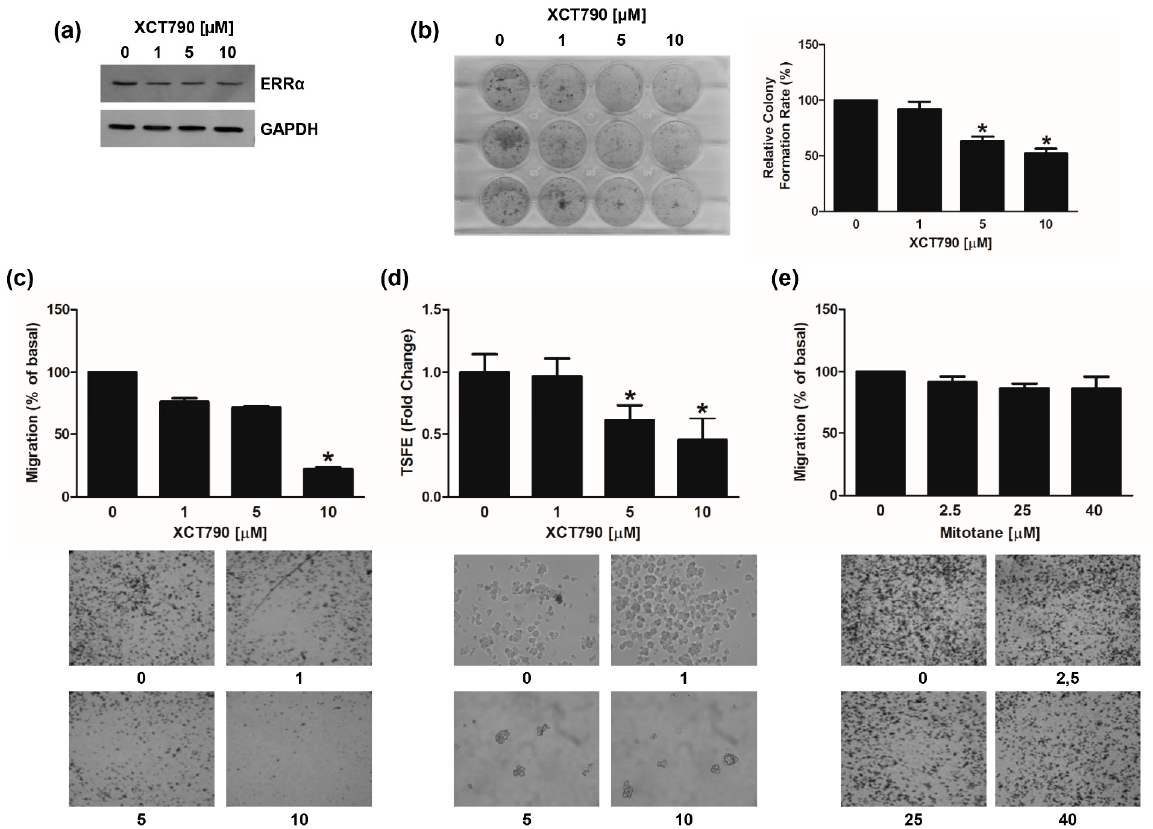
Figure 8. Effects of XCT790 treatment on MUC-1 cells. ( a ) MUC-1 cells were left untreated (0) or treated with XCT790 (1, 5, 10 µM) for 24 h. Total proteins were analyzed by WB using antibodies against ERR α . GAPDH was used as a loading control. Blots are from one experiment representative of three with similar results. ( b ) MUC-1 cells were seeded in 12-well plates and allowed to grow in the absence or presence of different XCT790 (1, 5, 10 µM) doses for 14 days. Colonies were stained with 0.05% Coomassie Blue in methanol/water/acetic acid (45:45:10, v / v/v ). Colony number (relative colony formation rate) was assessed using Image J software and normalized to untreated cells